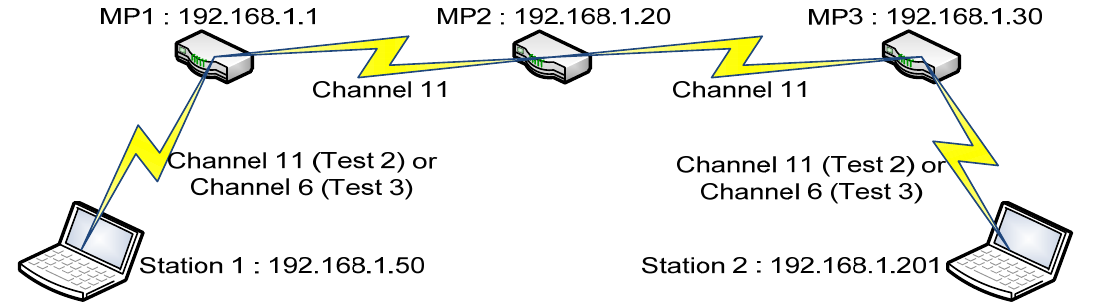
Figure 4. The 2 mobile stations that are connected to each other through the backhaul